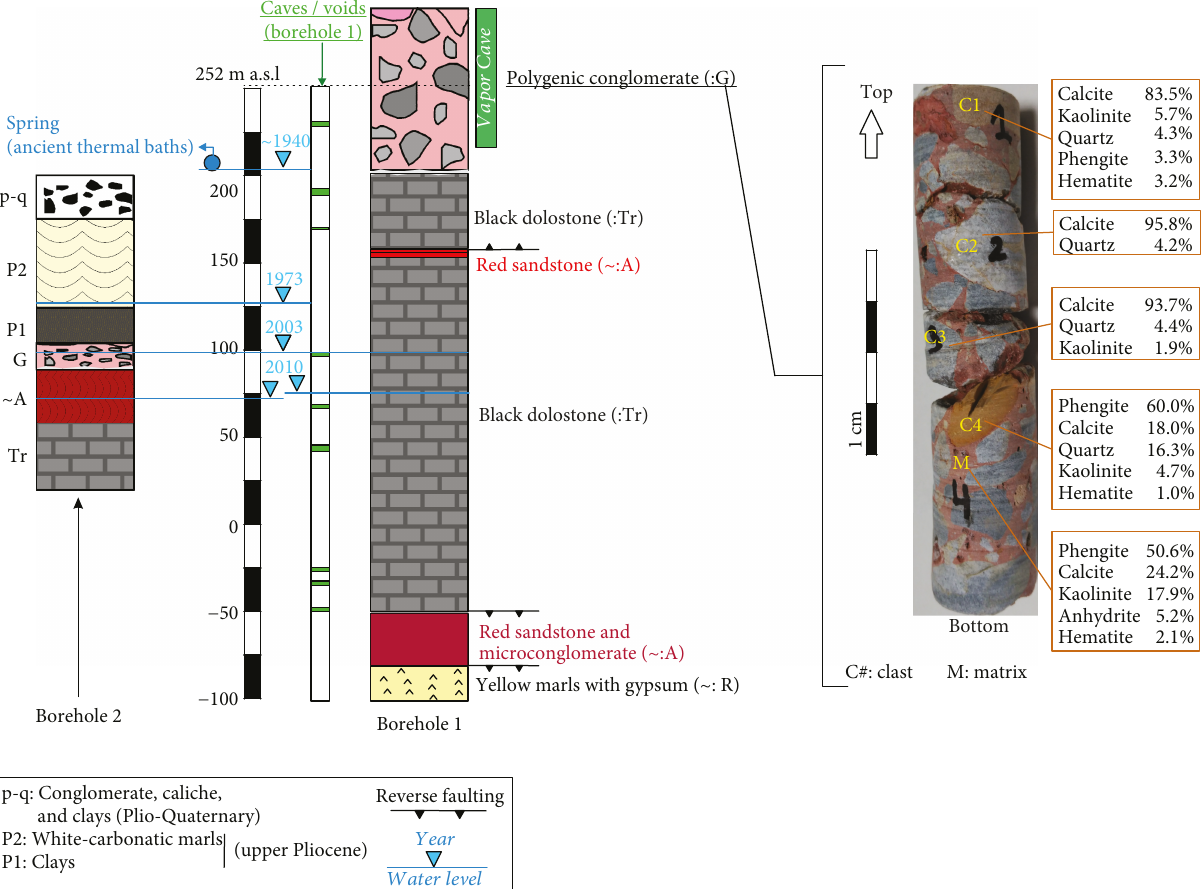
Figure 3: Lithological columns of two key boreholes near Vapour Cave; “ Cerro del Castillo ” (borehole 1) and “ Agua de Dios ” (borehole 2), both of them linked to the ancient thermal baths of Alhama de Murcia (southern Spain) (adapted from [17] and other unpublished technical reports provided by the Alhama de Murcia city council). Time evolution of water table and depths of the karsti fi ed sections (presence of caves and voids) are displayed in relation to lithologic units. The mineral composition (DRX analysis) of both clasts and matrix of a small core sample of the polygenic conglomerate (host rock of Vapour cave) is also